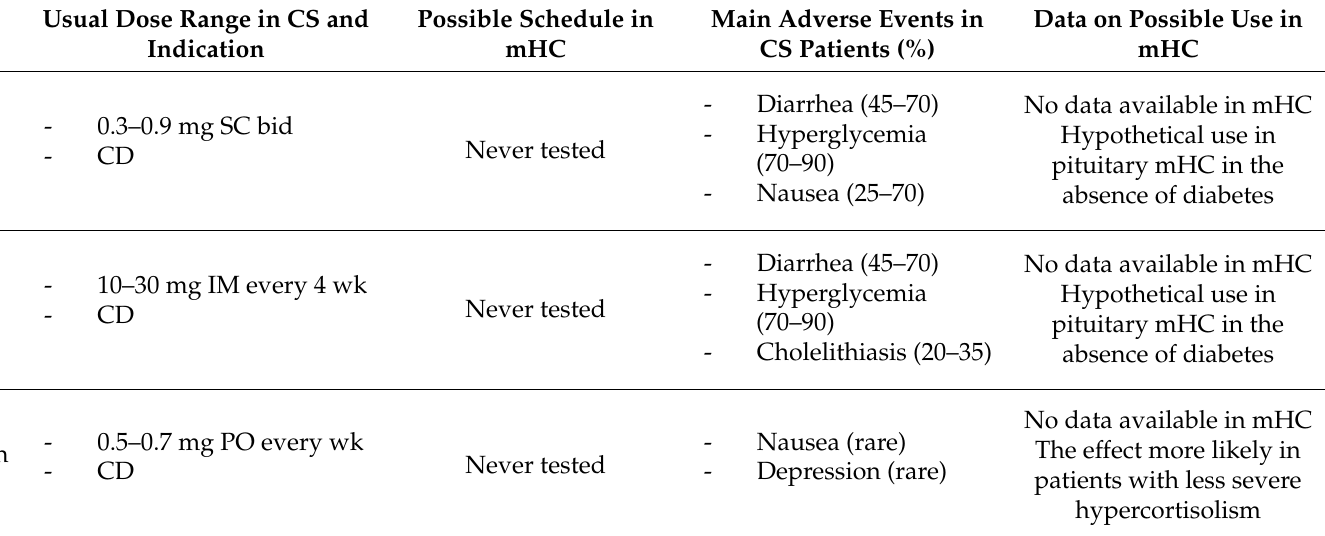
Table 1. Summary of mechanisms of action, dose range, adverse effect and clinical effects of the currently available drugs or possible new agents for treating mild